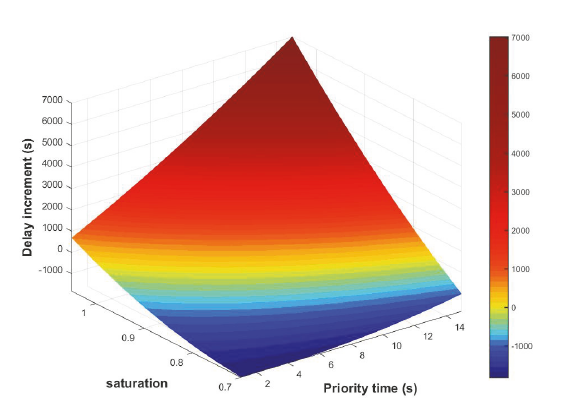
Figure 12: Sensitivity of the total delay increment as a function of the priority time and